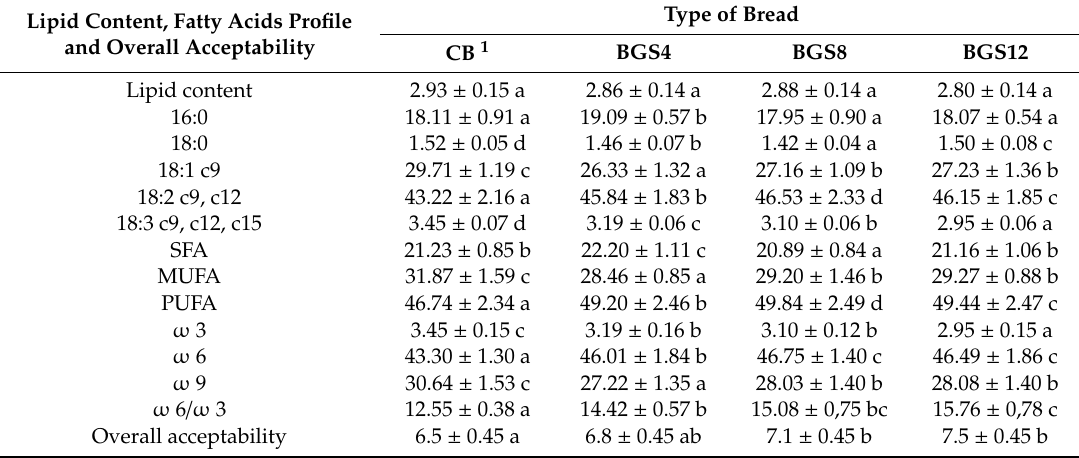
Table 8. Lipid content [%], the fatty acids profile [%] and overall acceptability in control bread and bread enriched with green spelt grain. Lipid Content, Fatty Acids